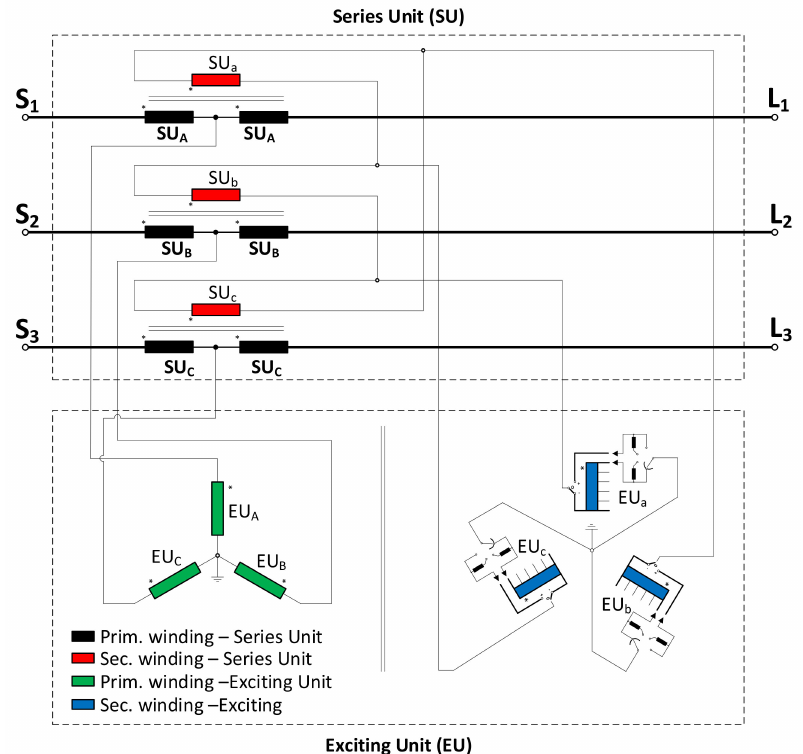
Figure 3. Connection diagram of windings for symmetrical dual-core PST (vector group IIId